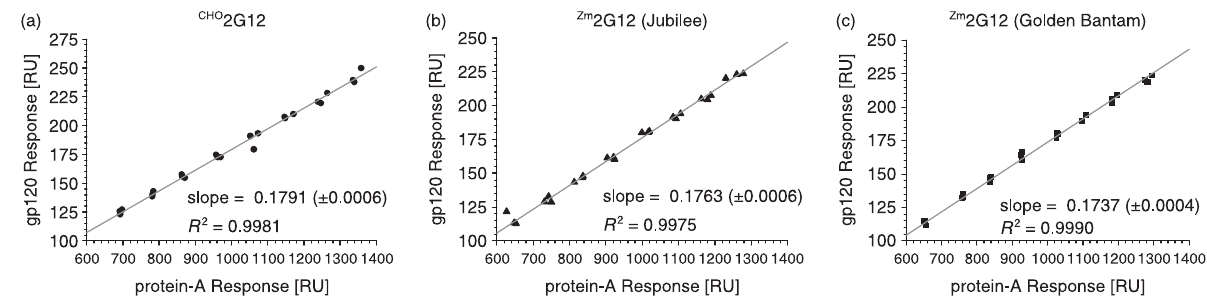
Figure 8 Signals obtained for 2G12 binding to protein A and gp120 surface. The gp120 response was plotted against the protein A response, and the slope representing the antigen-binding activity was determined by linear regression. The standard errors of the slopes are shown in parentheses. The reference CHO 2G12 (a) and two independent purifications of Zm 2G12 SEKDEL from backcrosses into Jubilee (b) and Golden Bantam (c) are shown.